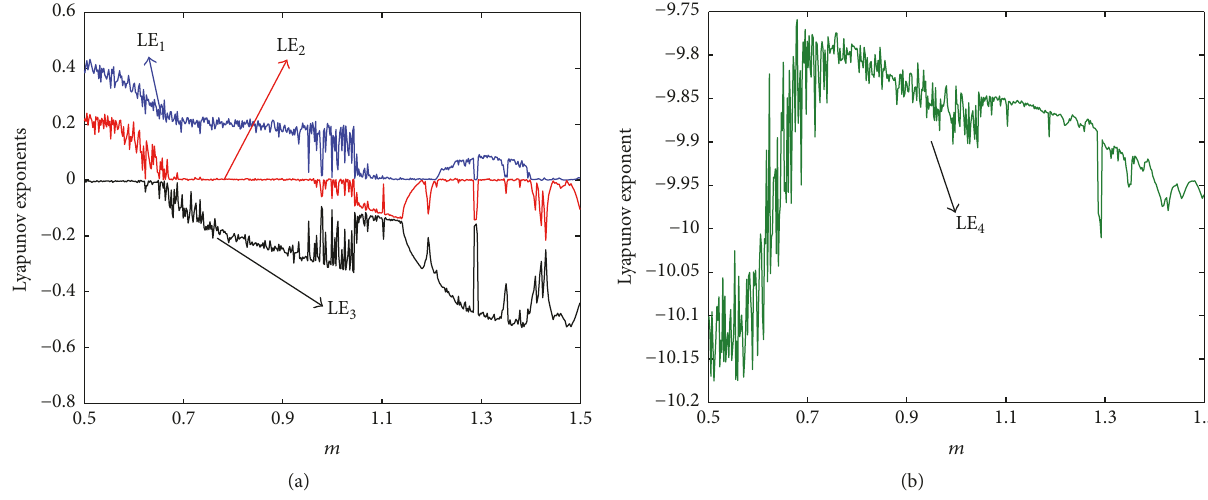
Figure 2: Lyapunov exponents LE 1 , LE 2 , LE 3 , and LE 4 of system (2) without equilibria versus parameter 𝑚 in [0.5, 1.5].